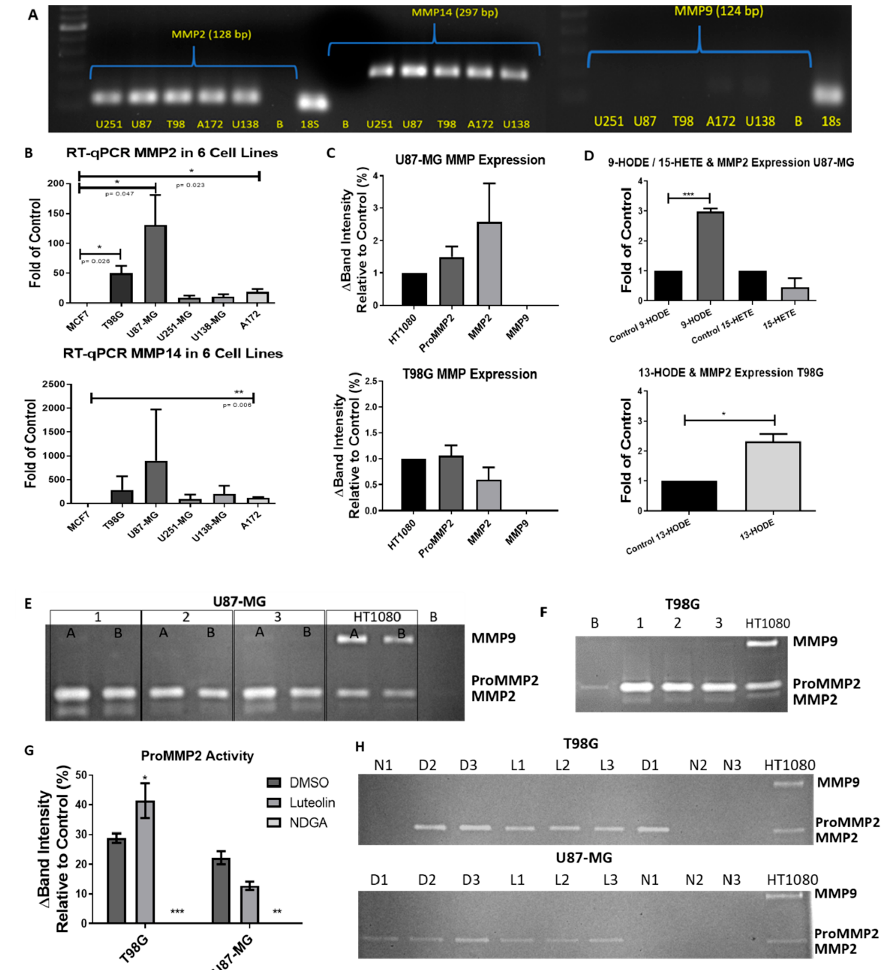
Figure 7. RT-PCR / zymography basal metalloprotease (MMP) expression in GBM cell lines. ( A ) RT-PCR gel electrophoresis of MMP-2, -9, and -14 in 5 GBM cell lines. MMP9 was poorly expressed. ( B ) qRT-PCR of the relative MMP expression in 5 GBM cell lines compared to MCF7. ( C ) Zymographies of baseline MMP expression in U87-MG (top) and T98G (bottom) cells were obtained by cultivation in T-25 plates with 2 mL of serum-free Dulbecco’s modified Eagle’s medium (DMEM) for 21 h. Relative intensities were adjusted by the number of cells counted in each plate when the medium was collected and compared with the HT1080 relative expression. ( D ) qRT-PCR expression of MMP2 mRNA after 72 h of treatments with HODEs and 15-HETE in U87-MG (top) and T98G (bottom). ( E ) Gelatin zymography of U87-MG samples cultivated in either 2 mL (Lane 1A) or 4 mL (Lane 1B) of the medium were run in duplicates. Each lane was a separately cultivated trial. Each band shows the relative activity of proMMP2 (72 kD), activated MMP2 (MMP2: 62 kD), and proMMP9 (92–82 kD) compared with the HT1080 fibrosarcoma cell line. ( F ) Zymography of the T98G cell medium. ( G ) Zymography values of proMMP2 expression after 72 h of treatment with 15-LOX inhibitors. ( H ) Zymography gels of T98G (top) and U87-MG (bottom). D1 , D2 and D3 = ( DMSO N = 1 , 2 and 3 ). L1 , L2 and L3 (luteolin N = 1 , 2 and 3 ). N1 , N2 and N3 (NDGA N = 1 , 2 and 3 ). B = blank. All experiments with N =